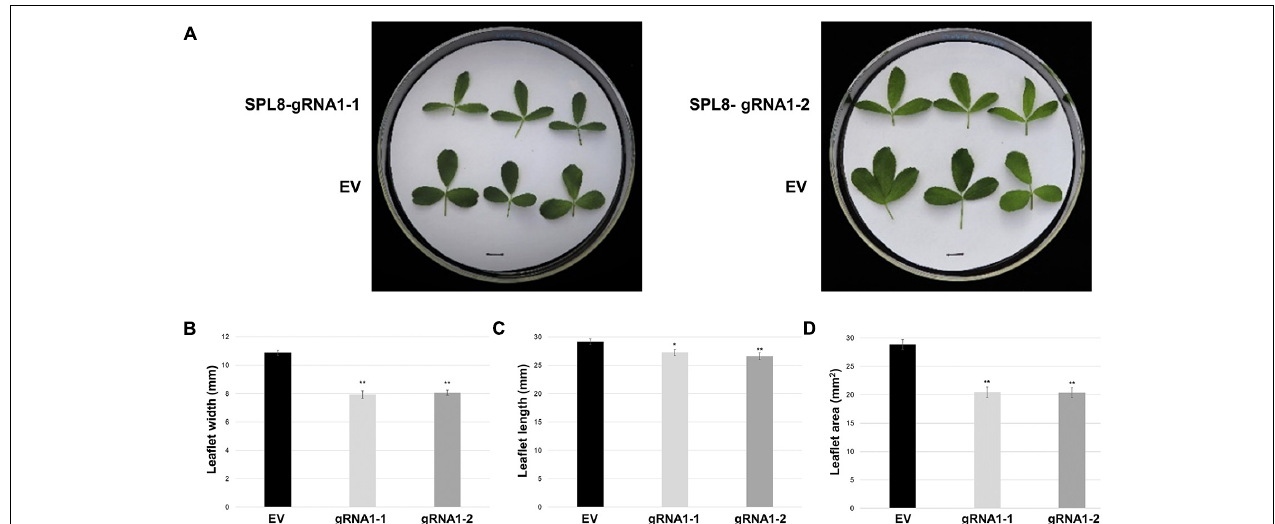
FIGURE 5 | Leaf characteristics of SPL8-gRNA1 and EV control genotypes. (A) Representative images of trifoliate leaves (third from the shoot tip) from edited SPL8-gRNA1-1 (mutations in three MsSPL8 alleles) and SPL8-gRNA1-2 (mutations in two MsSPL8 alleles) genotypes, as well as empty vector (EV) controls. Scale bars = 1 cm. (B–D) Measurements of the width, length and area of the middle leaflet of trifoliate leaves (third from the shoot tip) at 30 days after cutting. Each block represents the mean of three leaflets from five biological replicates of each SPL8-gRNA1 genotype, and five biological replicates from each of three independent EV transformants (fifteen replicates total), while bars denote standard errors. Asterisks denote means that are significantly different from EV controls as determined by 2-tailed student’s t -tests assuming unequal variance (* P ≤ 0.05; ** P ≤ 0.01).